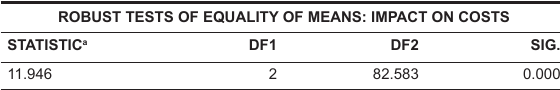
TABLE 17 Test statistics of the Kruskal-Wallis test (question